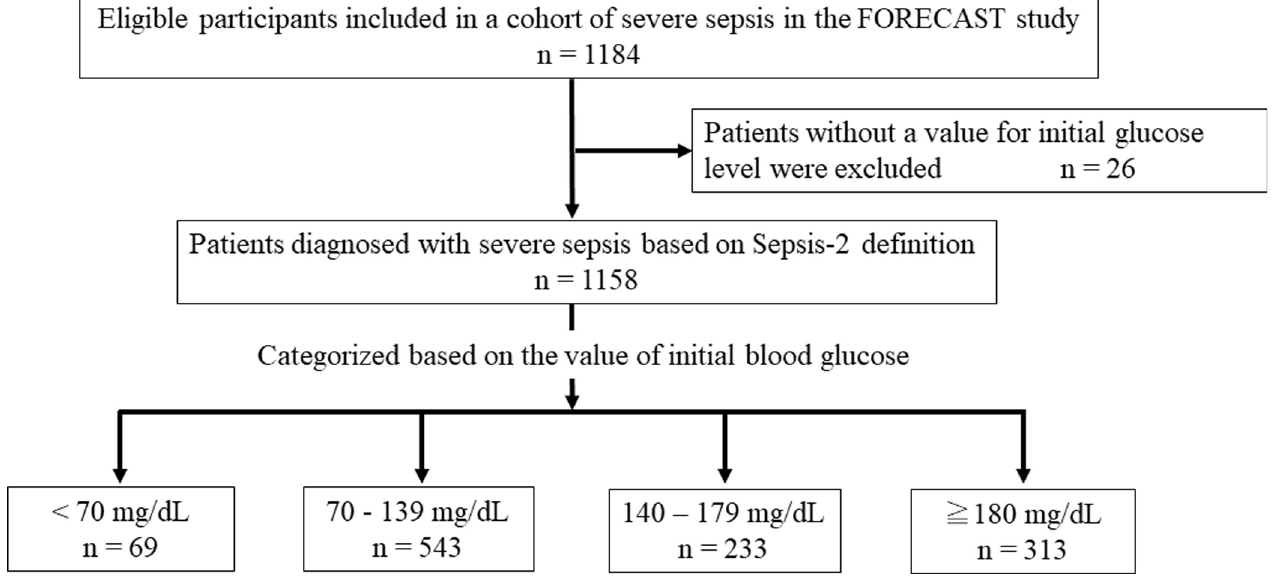
Fig 1. Flow chart of subject selection and blood glucose